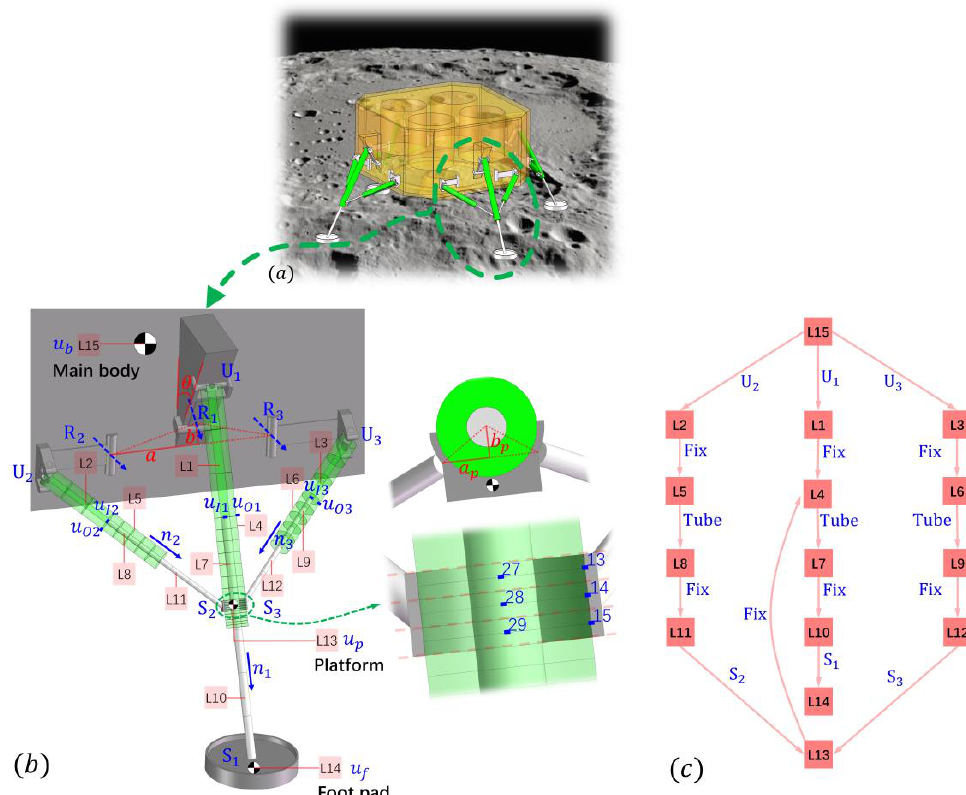
Figure 4. ( a ) The reconfigurable lunar lander mechanism. ( b ) One leg of the lunar lander and its link number and node number. ( c ) The topology graph and connection type of links.